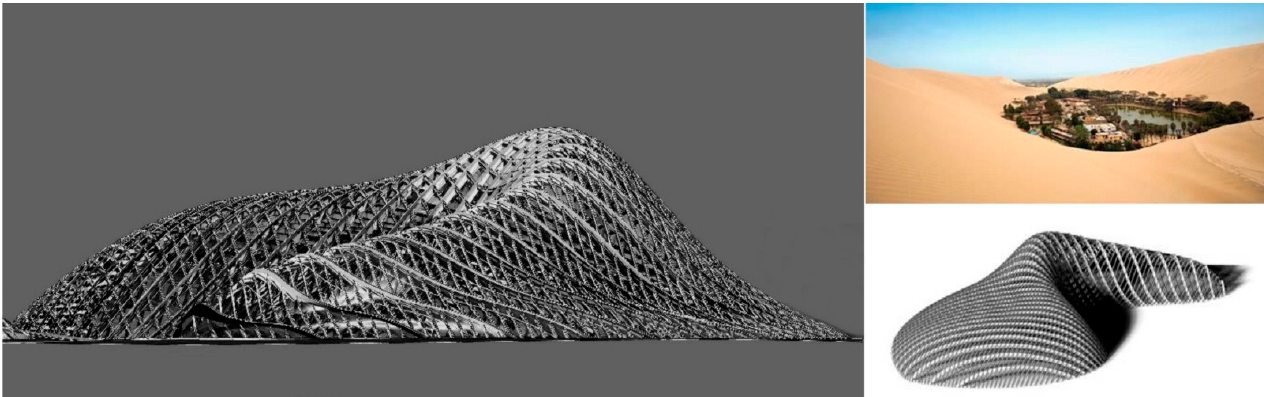
Figure 5. Anthropogenic Oasis Aqua Park, digital tectonic models.